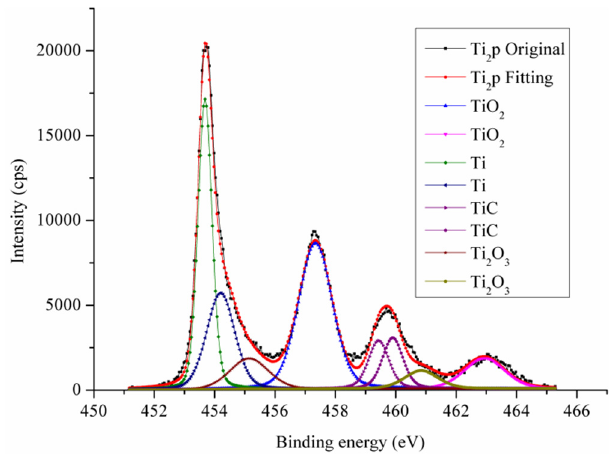
Figure 7. Electronic spectra of Ti 2 p characteristic peak on corrosion interface of titanium alloy in argon.